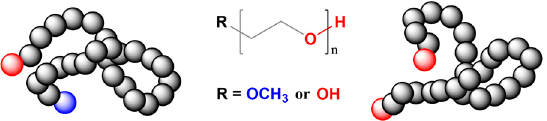
Figure 1. Schematic representation of an α -methoxy poly(ethylene glycol) (mPEG) with an ω -hydroxyl group and the corresponding PEGdiol.